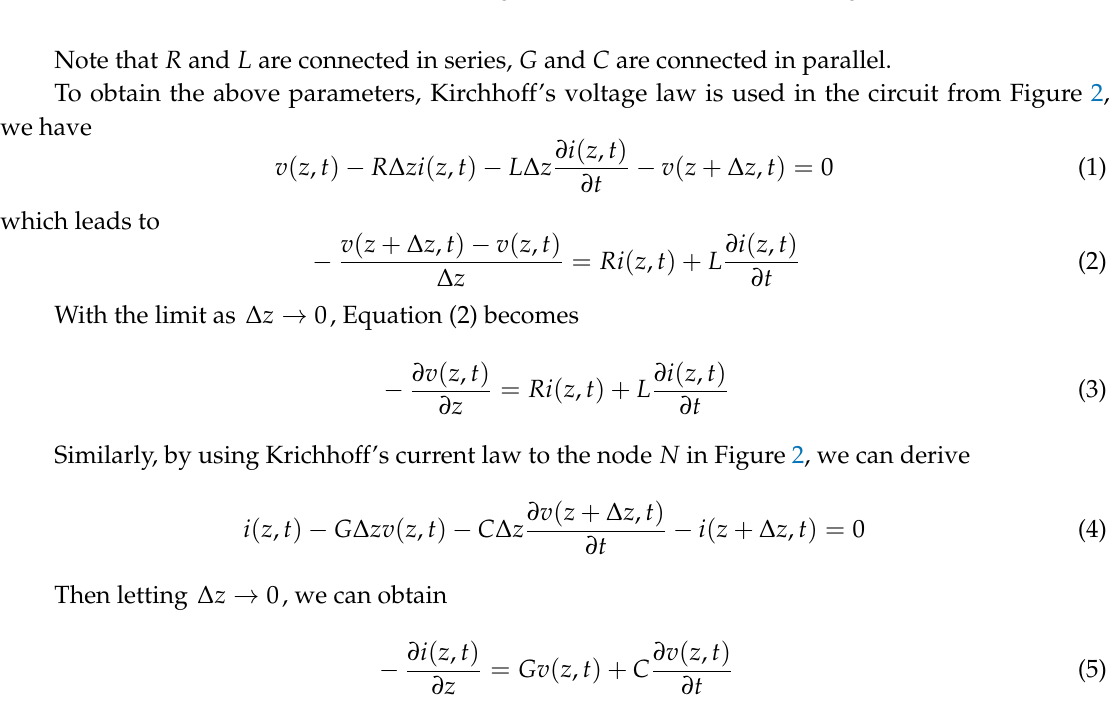
Figure 2. The circuit structure diagram of a transmission line of a length of Δ z .